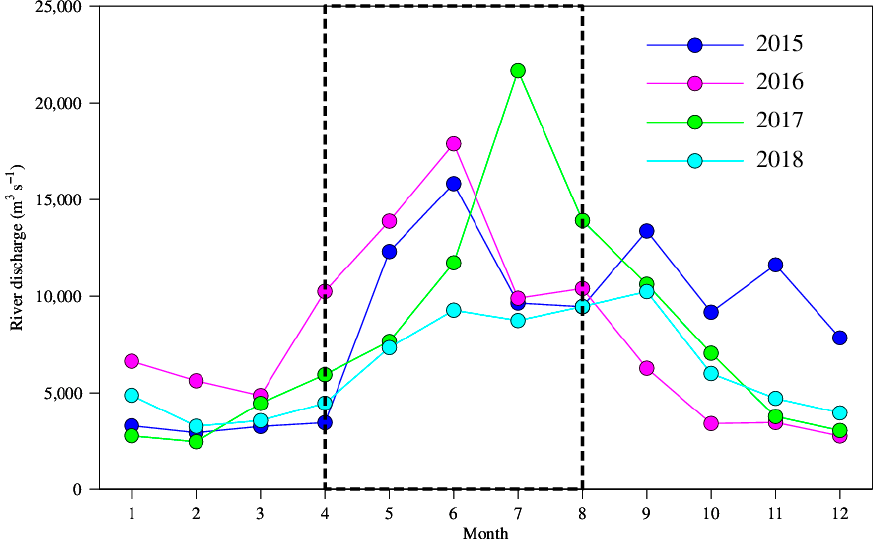
Figure 6. Monthly river discharge at the Gaoyao hydrological station, from 2015 to 2018.